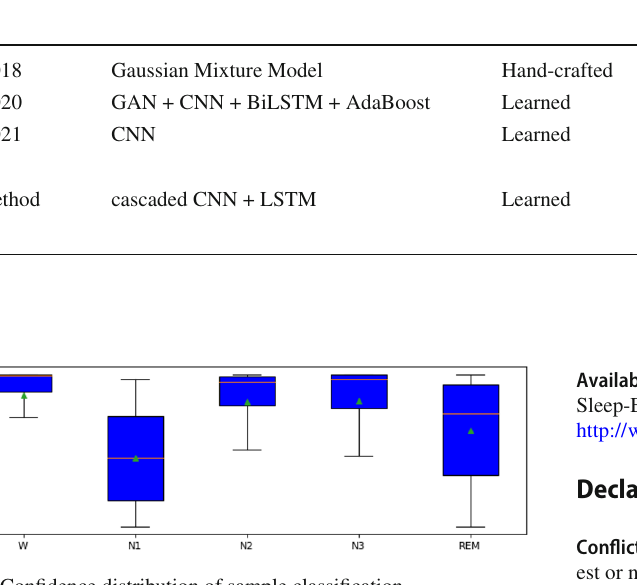
Fig. 3 Confidence distribution of sample